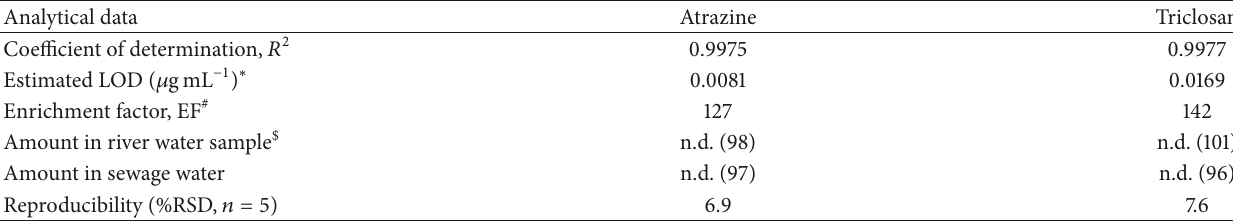
Table 1: Some analytical data obtained from the regression analysis.